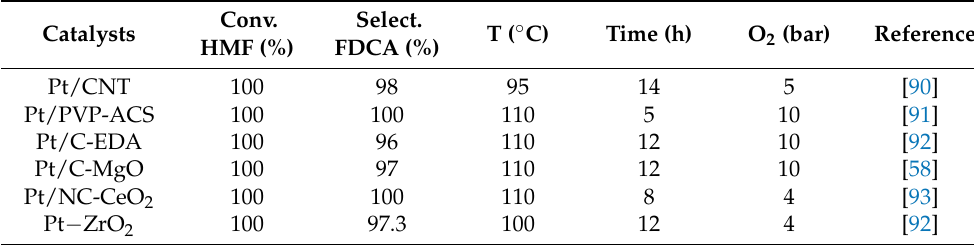
Table 1. The oxidation of HMF to FDCA via Pt catalysts.